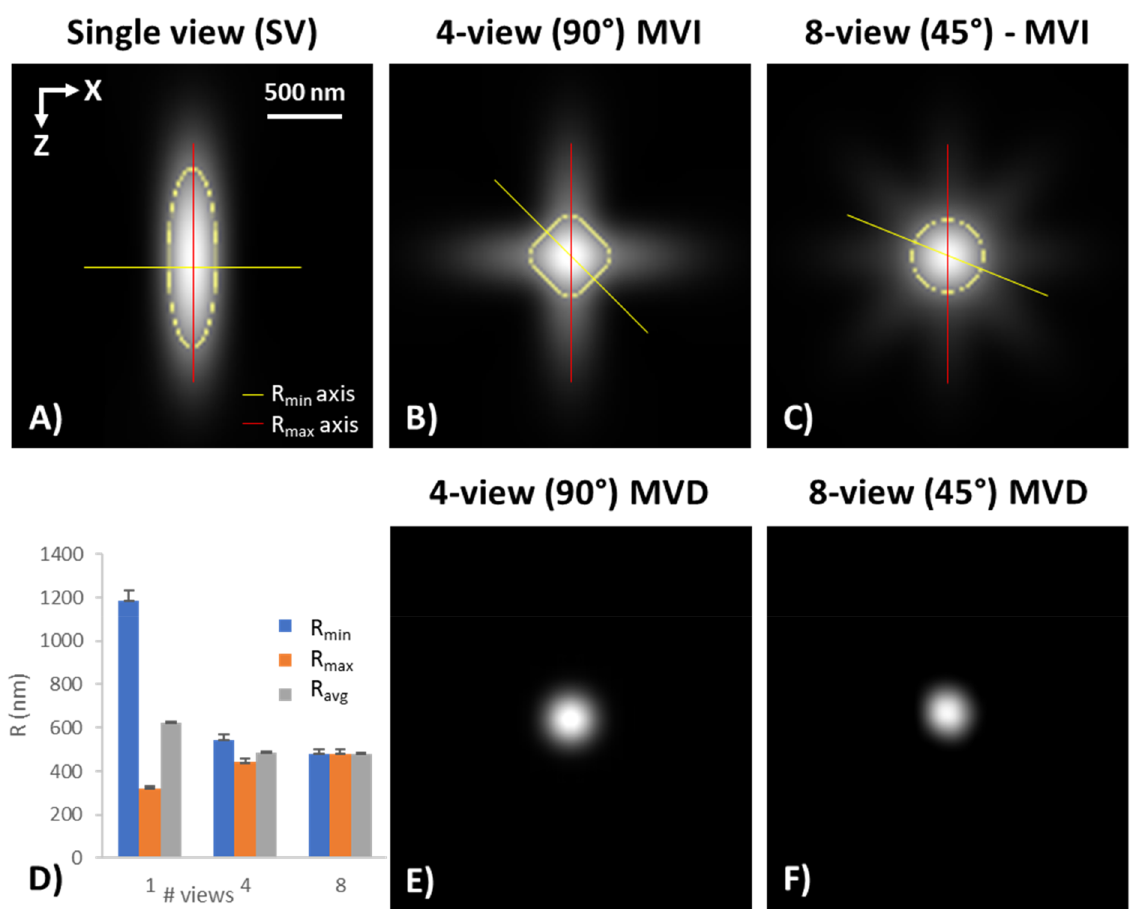
Figure 2. Multiview resolution. ( A – C ) Cross section of the PSF of ( A ) Single View (SV), ( B ) 4-views MVI, and ( C ) 8-views MVI. The yellow line indicates the axis of R min , the red line the axis of R max , and the yellow dotted line the area of the FWHM from which R avg is extracted. ( D ) Graph of the R min , R max and R avg of the PSFs in ( A – C ). ( E ) 4-view deconvolved PSF of 2B. F ) 8-view deconvolved PSF of 2C. (Images were created with Fiji 26 tive of NA:1.0, water immersion, at 820 nm excitation. The MVI PSF was calculated by rotating the PSF of the SV with steps of 90° for the 4-view MVI and 45° for the 8-view MVI. The individual rotated PSFs of each view were added to create the MVI PSF for 4- and 8-view MVI. The resulting PSFs can be seen in Fig. 2. The MVI PSF was further deconvolved to produce the corresponding MVD. The PSF of the SV (Fig. 2a) appears as an ellipsoid. The minimum resolution of a SV is found in the lateral (XY) axis and is 320 ± 13 nm, while the maximum in the Z axis (XZ or YZ) is 1183 ± 49 nm, in good agreement with the theoretical estimation 1 . The yellow dotted line in Fig. 2A indicates the Full width at half maximum (FWHM) in all directions around the centre. The average resolution was calculated as the effective diameter of the area formed by the FWHM, and it was found to be 624 ± 6 nm. Similar calculations were made for the 4-view MVI PSF in Fig. 2b. The PSF is maximum on the same axis as in the SV and was found to be 545 ± 23 nm, which is significantly smaller compared to that in SV. The axis where the PSF becomes minimum (R min ) is located at 45°, in reference to the axis of maximum diameter of the PSF(R max ), and it was 440 ± 18 nm; slightly bigger com- pared to that of the SV. The average PSF diameter based on the FWHM (R avg ) was 485 ± 5 nm which is smaller compared to that observed in the SV. For 8-view MVI (Fig. 2c) the maximum PSF diameter was 480 ± 20 nm, minimum 480 ± 20 nm, and average 480 ± 5 nm. Anisotropy in resolution, defined as the ratio of lateral to axial resolution or equivalently as the ratio of R min over R max , is 0.27 for SV, 0.80 for 4-view, and 1.00 for 8-view, thus in 8-view MVI configuration, isotropic resolution is achieved. The MVI PSFs were deconvolved using the Multiview Reconstruction 8 plugin of Fiji 26 and the SV PSF. The resulting deconvolved PSFs showed higher resolution with R min : 230 ± 10 nm, R max : 0.26 ± 10 nm for 4-view, and R min : 240 ± 10 nm R max : 240 ± 10 nm for 8-view MVD. Anisotropy is further improved with anisotropy of 0.88 for 4-views and 1.00 for 8-view. The corresponding deconvolved PSFs are presented in Fig. 2E and F. Comparing the average MVI resolution of 8-, and 4-views to the SV, it becomes evident that MVI produces PSFs with smaller average dimensions, therefore offering better overall resolution. This is accomplished because the resolution is more isotropic compared to that in SV. The maximum and minimum PSF diameter tend to equalize with higher view number. While the absolute minimum in resolution can be achieved with SV in the XY plane, MVI will improve the average resolution. The 8-view MVI does offer the best average resolution (480 nm),